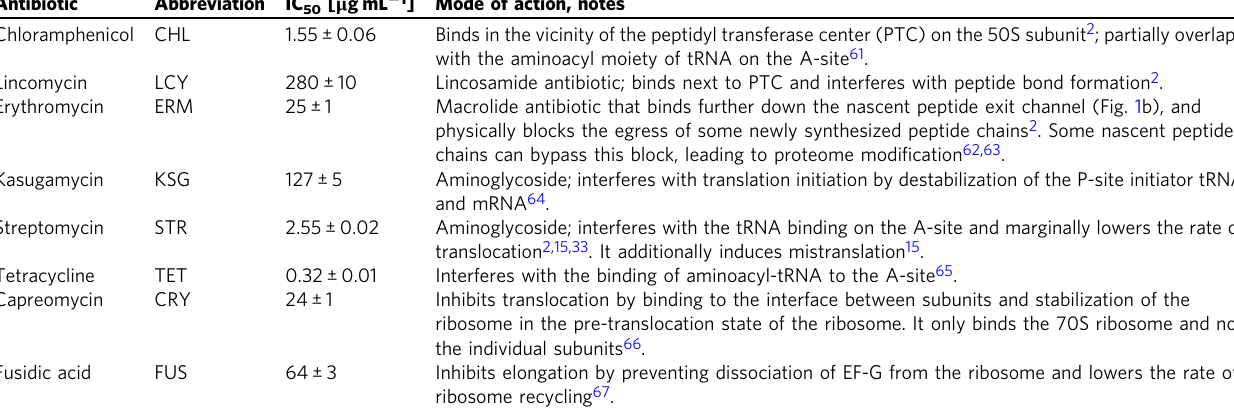
Table 1 Translation-targeting antibiotics used in this study.